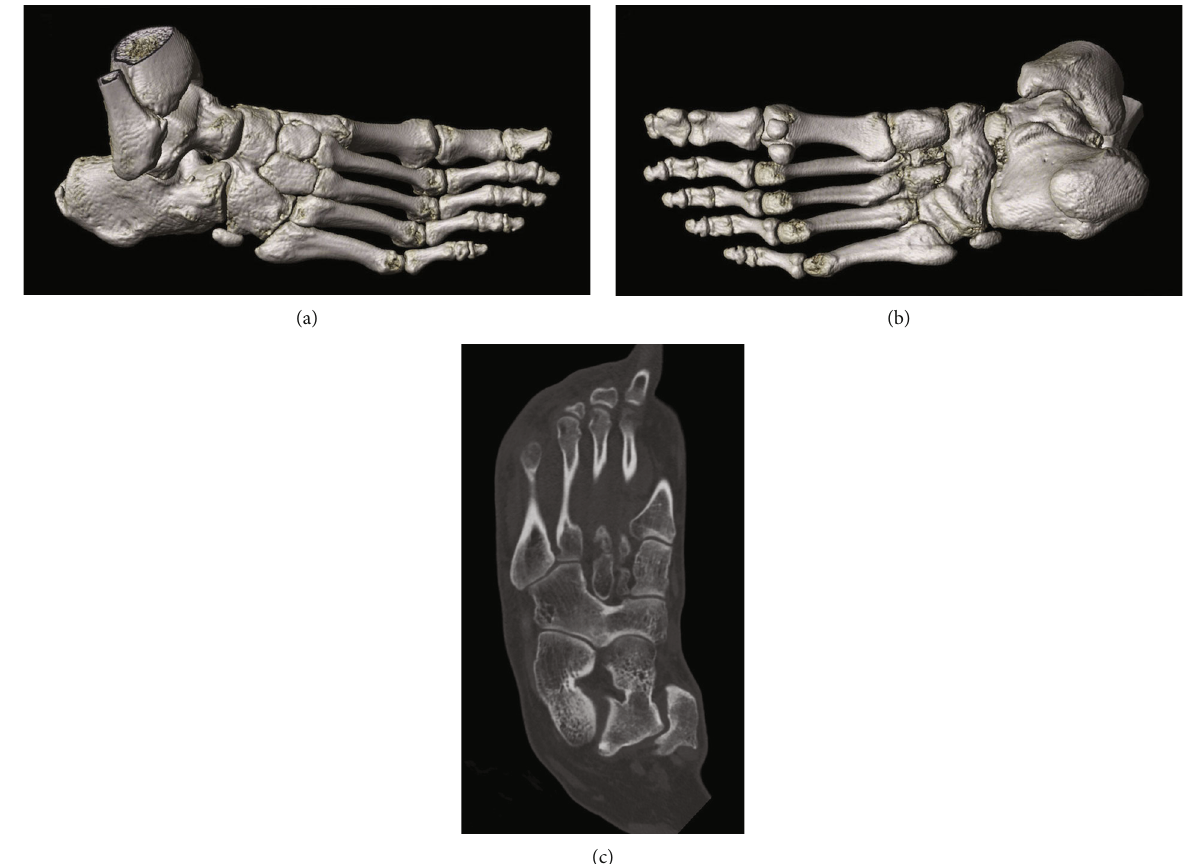
Figure 5: Osseous cubonavicular coalition of the right foot. Dorsolateral (a) and plantar (b) volume rendered CT images show the cuboidonavicular complex and its close relationship with the peripheral bones of the hindfoot and forefoot. Oblique multiplanar reconstruction CT image (c) shows as well as MRI the perfect continuity of the bone marrow and joint surfaces.